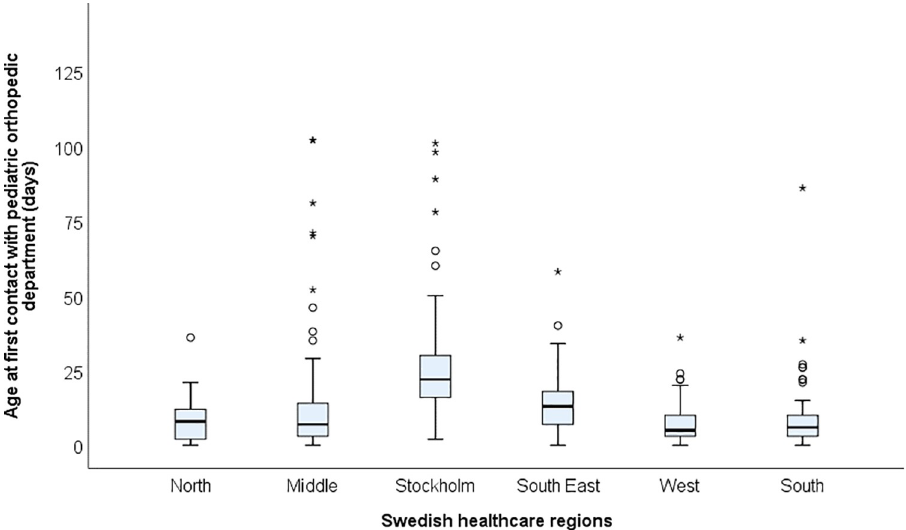
Fig 2. Time between birth and first contact with a pediatric orthopedic department. Children born with clubfoot from 2016 to 2019, divided between the six national health care regions. Outliers (circles) and extremes (asterisks) are also shown. One extreme at 186 days in the Middle region is not shown for scaling purposes.